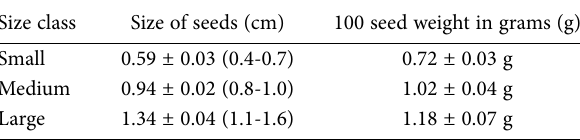
Table 5. Different seed size classes in A. glauca.